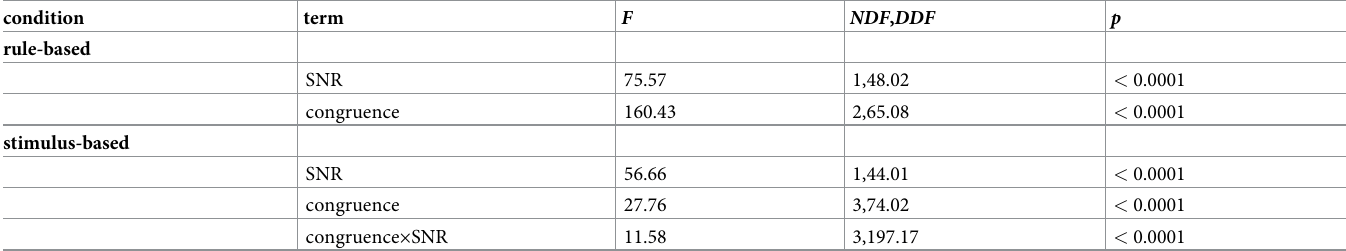
Table 2. Mixed-effects RT model ANOVAs. NDF : numerator degrees of freedom; DDF : denominator degrees of freedom. Denominator degrees of freedom were esti- mated using the Kenward-Roger method. condition